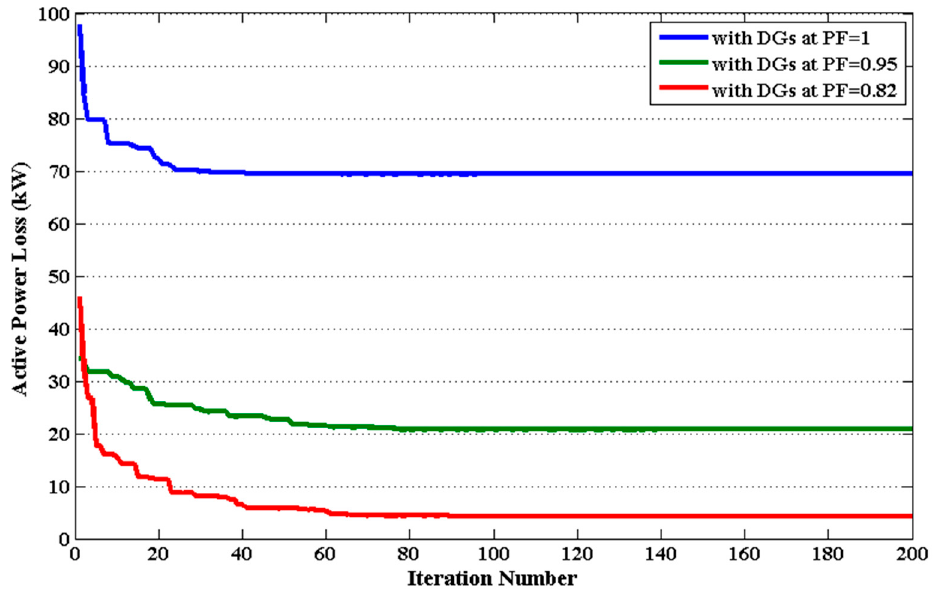
Figure 11. Convergence characteristics for Case 1 of the IEEE 69-bus system using QODELFA.